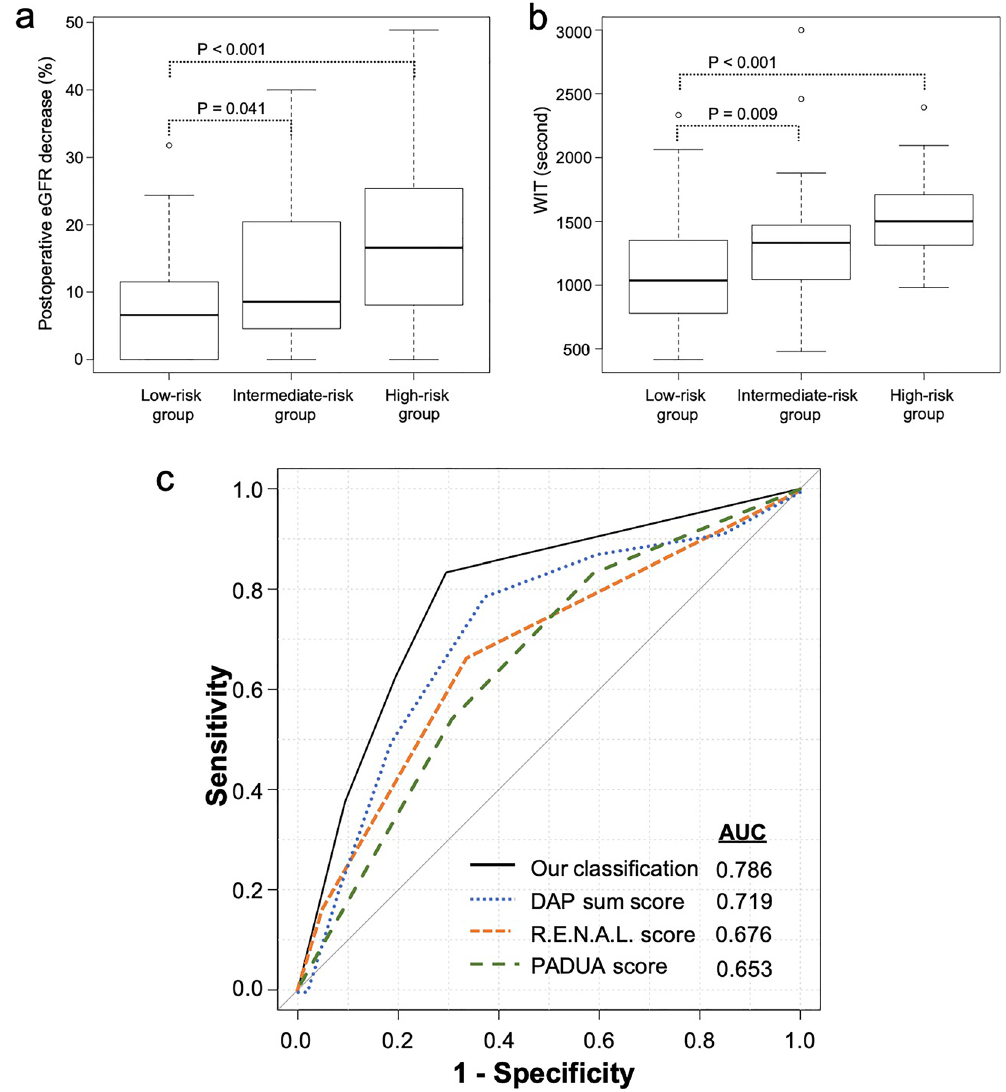
the DAP sum score, the R.E.N.A.L. score, and the PADUA score for predicting eGFR reduction of ≥ 20%. AUC area under the receiver operating characteristic curve; DAP diameter-axial-polar, eGFR estimated glomerular filtration rate; PADUA preoperative aspects and dimensions used for anatomic; R.E.N.A.L. radius, exophytic/ endophytic, nearness to collecting system or sinus, anterior/posterior, and location relative to polar lines, WIT warm ischemic